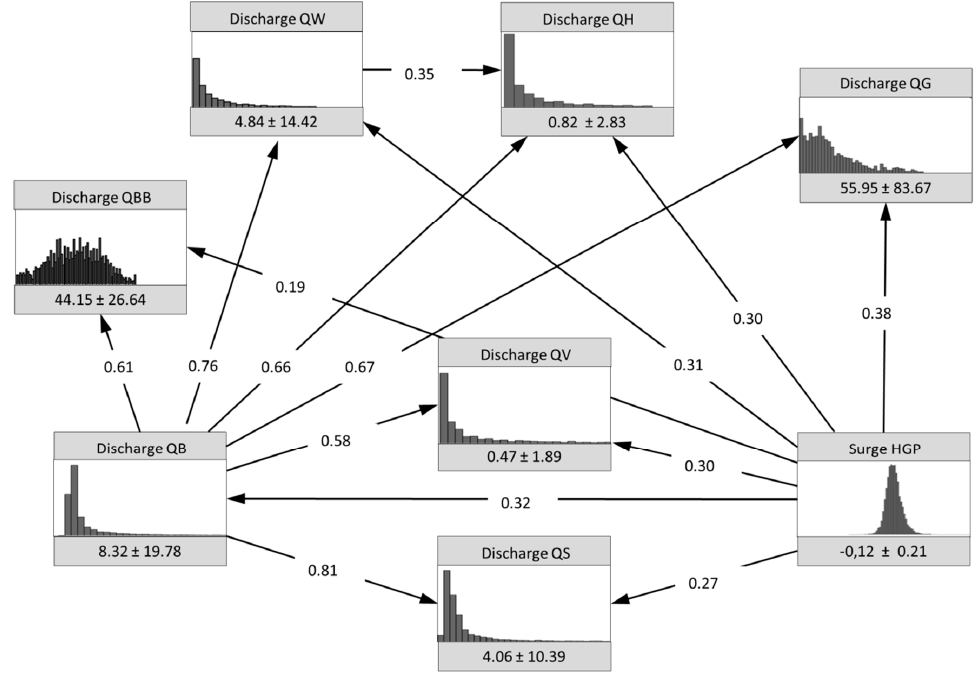
Figure 3. The Bayesian Network model for the Buffalo Bayou catchment. The boxes represent the nodes and the arrows the arcs. The values of the (conditional) rank correlation coefficient are shown on each arc. The histogram in the node shows the empirical probability distribution function for each variable and the values below represent the mean and standard deviation, respectively. Units are in m 3 s ‐ 1 for discharge and in m for the storm surge.